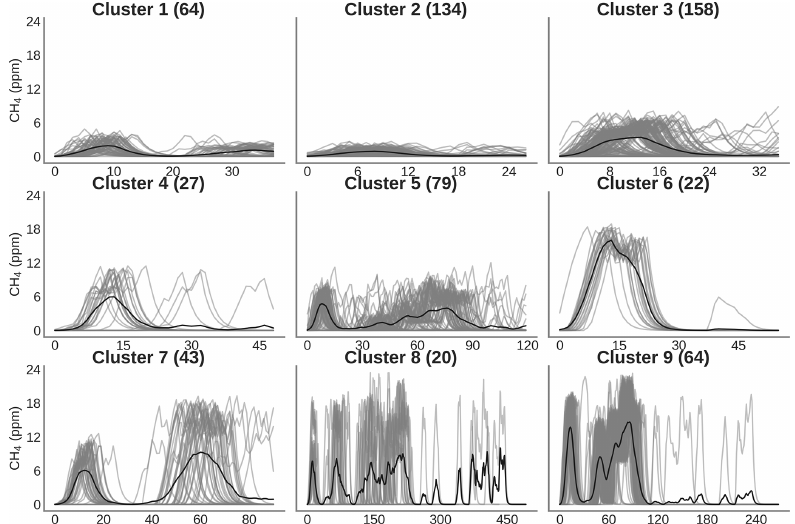
Figure A10. Clustering of peaks using DTW on the reference instrument for the same spikes detected by sensors on chamber D. On the title of each plot, the number inside the parentheses corresponds to the number of spikes attributed to each cluster. Thin gray lines represent all the peaks inside each cluster, and the black line is the mean of all the peaks corresponding to each class.